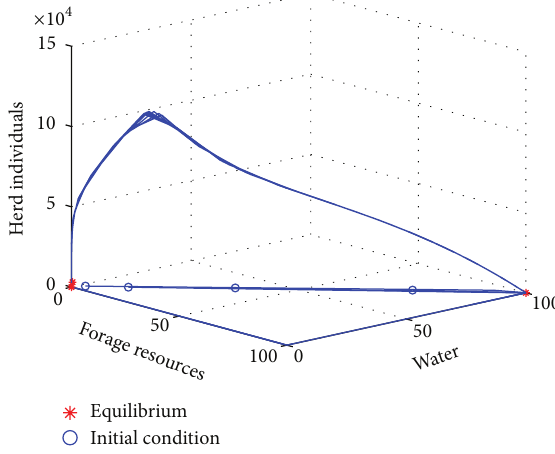
Figure 12: (a) Chronological evolution of herd’s animals, forage, and water resources of System (2). We observe the global stability of equilibrium 𝐸 13 = (𝐾 1 ,𝐾 2 ,0) when 𝑟 1 = 200 kgDM/ha, 𝑟 2 = = 800 kgDM/ha, and 𝐾 = 300 kgDM/ha, 𝑝 = 600 mm, 𝐾 Figure 11: Illustration of periodicity of the trajectories at equilib- 1 2 900 kgDM/ha. (b) Phase portrait of System (2) showing the local rium 𝐸 2 = (𝑅 ∗ ,𝑊 ∗ ,𝐻 ∗ ) for System (2). Alternative peaks are stabilityofequilibria 𝐸 11 and 𝐸 12 .TherestofparametersareinTables observed between the trajectories of the flock, feed resources, and 1 and water resources when 𝑟 1 = 800 kgDM/ha, 𝑟 2 = 700 kgDM/ha, = 1000 kgDM/ha, and 𝐾 = 900 kgDM/ha. The 𝑝 = 600 mm, 𝐾 1 2 rest of parameters are in Tables 1 and 2.